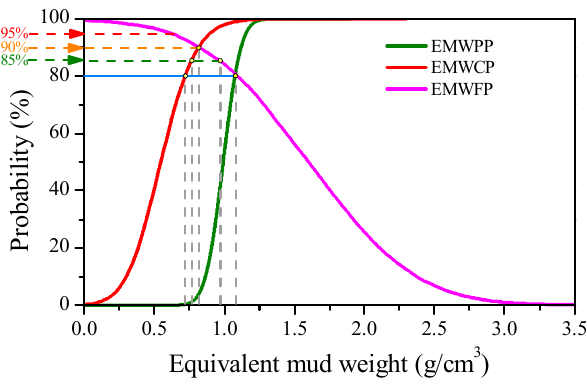
Figure 20. Probability density histogram of SMWW. Energies 2019 , 12 , x FOR PEER REVIEW